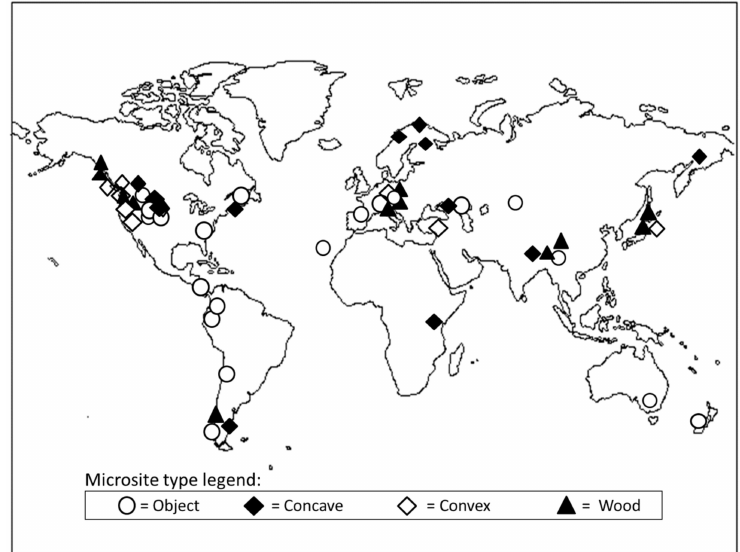
Figure 2. Dominant microsite types for seedling regeneration in the alpine treeline ecotone (ATE) around the world. Sites were selected by searching literature with initial search terms including: microsite, timberline, forest line, treeline, subalpine, alpine, mountain, seedlings, advance, precipitation, facilitation, and regeneration. Relevant literature was di ff erentiated into four ATE microsite types (see Supplemental Information for associated